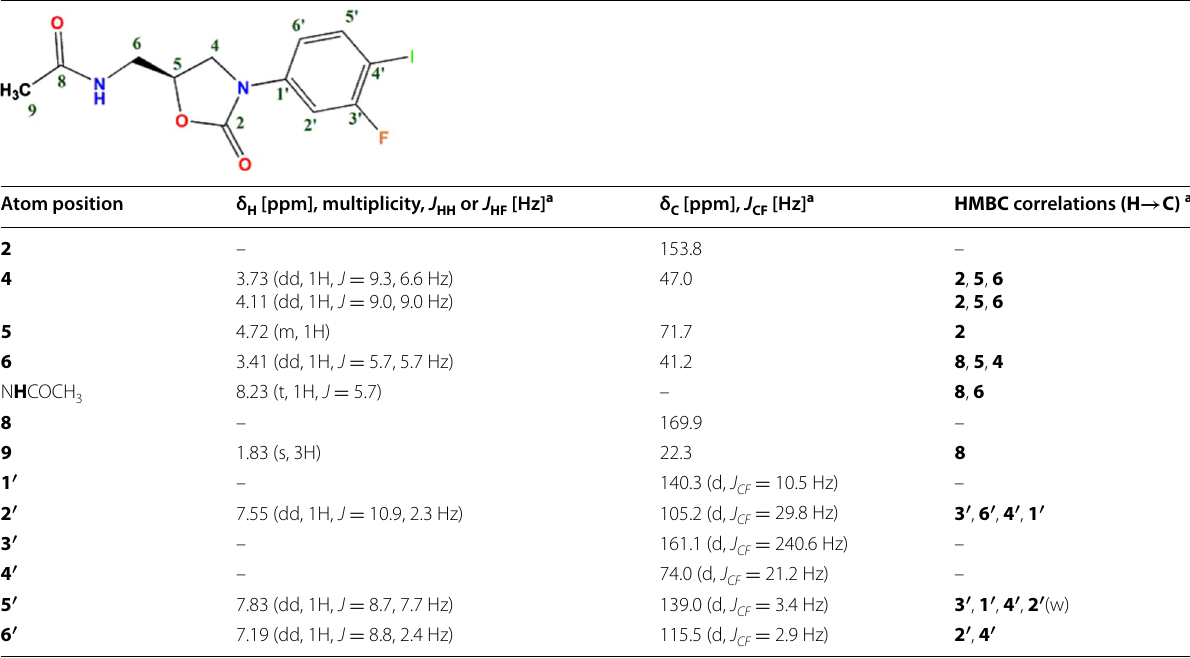
Table 4 1D and 2D-NMR data of 9 in DMSO (2.504 ppm- 1 H/39.4 ppm- 13 C) at 500